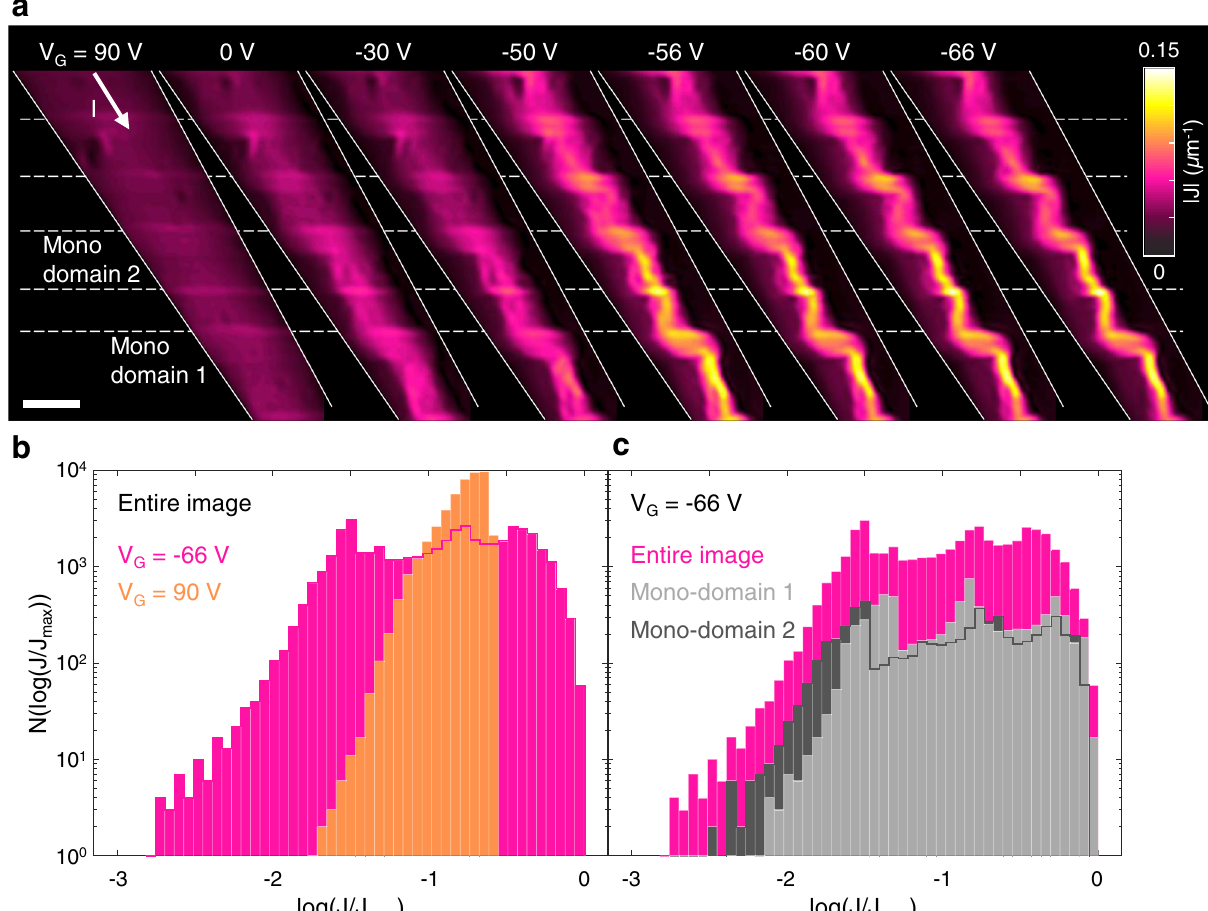
Fig. 2 Non-universal current backbone in a multi-domain device. a Current density images of a multi-domain region of sample C1, as a function of V G . Reducing V G , mono-domain regions became more inhomogeneous, while the boundaries remained conducting. As a result, more current fl owed along the boundaries. The rightmost image shows complicated current paths in the mono-domain regions, interrupted by the boundaries. In such patterns the current-carrying backbone cannot have the universal fractal scaling dimension. The solid white lines indicate the edges of the pattern. The dashed white lines indicate positions of domains. Scale bar, 30 µ m. b Logarithmically binned histogram of the current density of the leftmost and rightmost maps in a , transitioning from highly homogeneous conductivity on the metallic side, characterized by a narrow current distribution to disordered fl ow closer to the MIT, where the histograms spans three decades of current density. c Histograms of two mono-domain regions at V G = − 66 V, showing variations in the current distributions between different mono-domains, particularly in the width of the distributions, and in the low-current